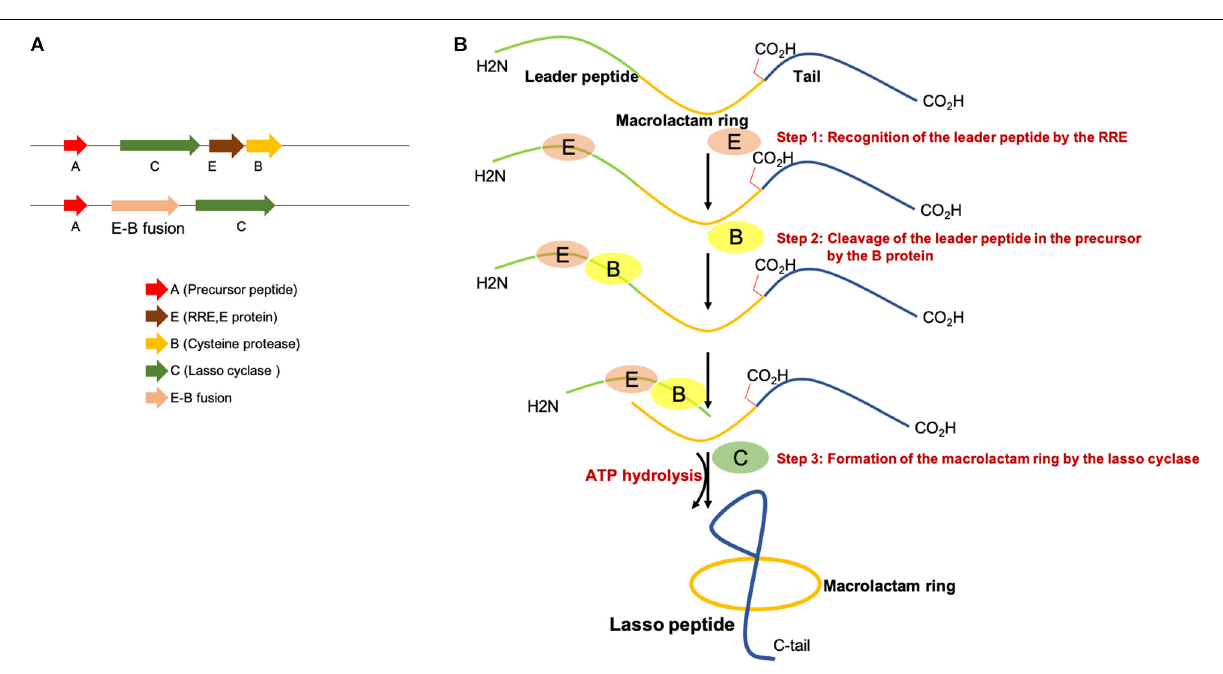
2013a,b, 2014; Maksimov and Link, 2013; Zimmermann et al., 2013, 2014Metelev et al., 2015; Zhao et al., 2016; Su et al.,